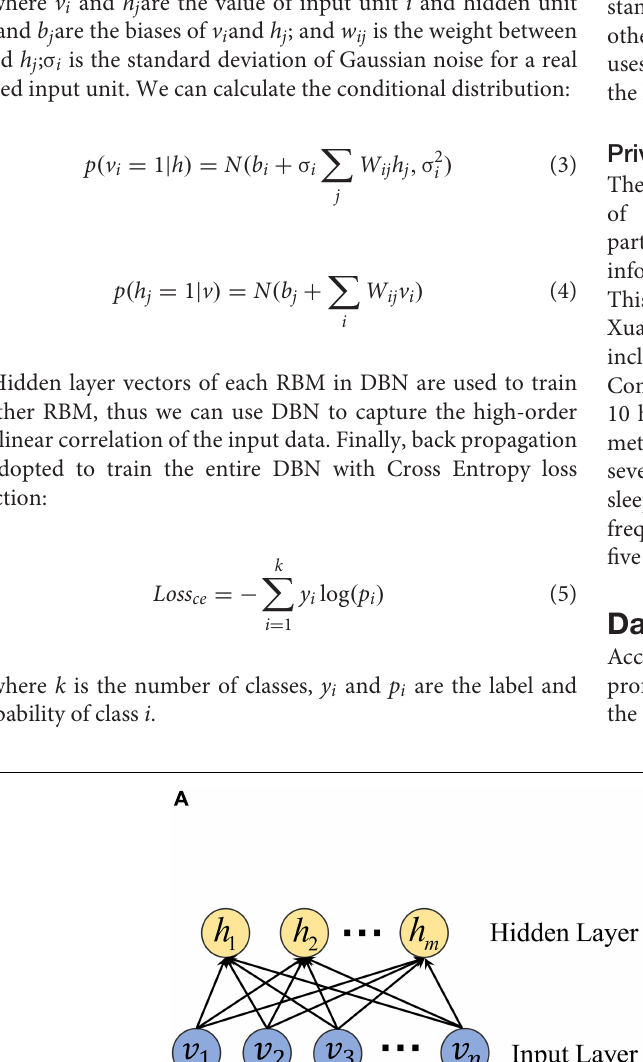
Frontiers in Human Neuroscience |